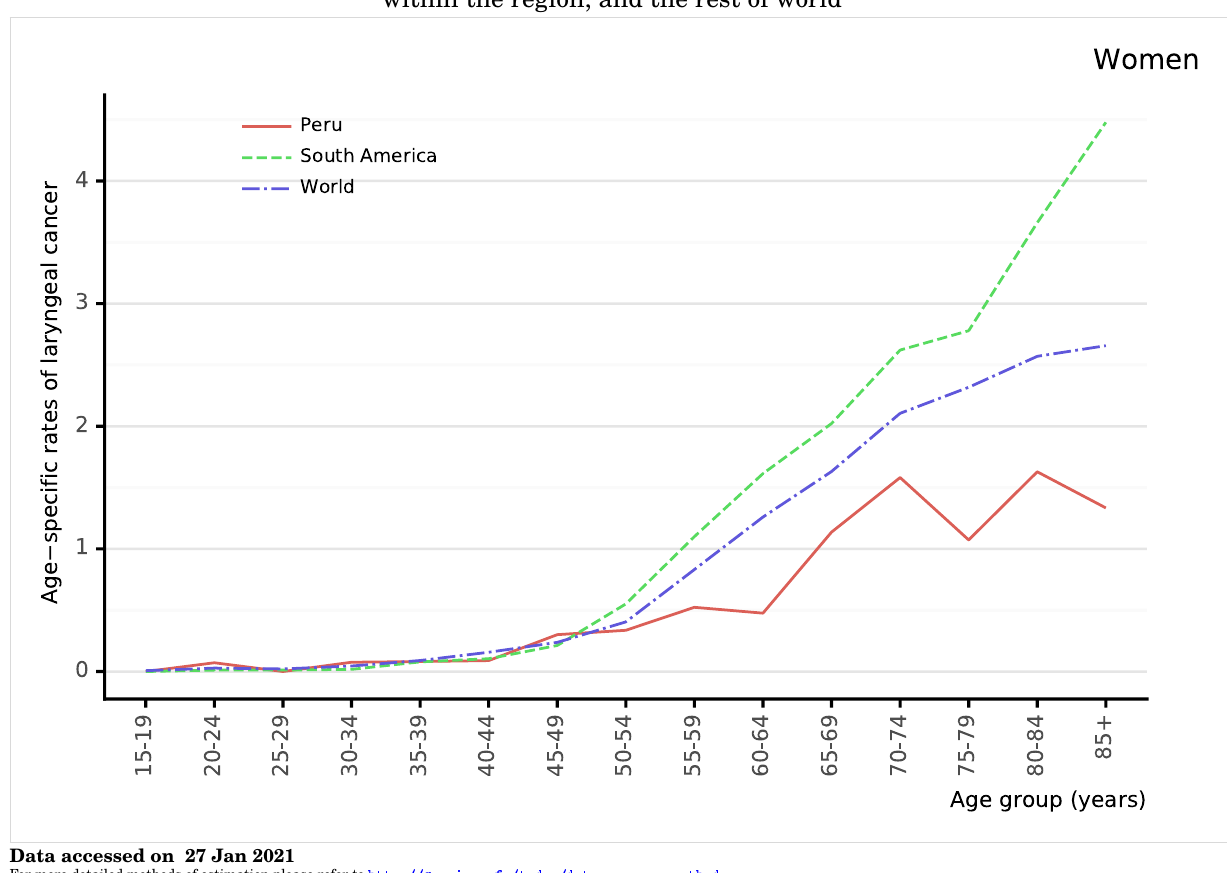
Figure 136: Comparison of age-specific laryngeal cancer mortality rates among women by age in Peru, within the region, and the rest of